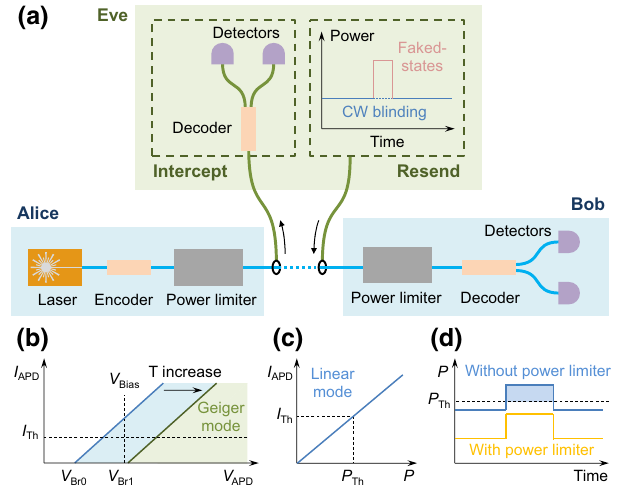
FIG. 8. (a) A schematic of the detector blinding attack pro- posed in Ref. [43]. (b) The current-voltage relationship of a typical APD. In normal working conditions, the breakdown volt- age is V Br0 . A fixed bias voltage V Bias > V Br0 enables Geiger mode operation with single-photon sensitivity. The resulting out- put current above a threshold I Th is registered as a successful count. However, the breakdown voltage increases with the tem- perature T of the device. Thus, it is possible to blind the detector by driving it into the linear mode ( V Bias < V Br1 ), thus nullifying the single-photon sensitivity. (c) The current-input power rela- tionship of an APD operating in linear mode. By controlling the input power below or above the power threshold P Th , the detector could be controlled to register fake states. (d) The input power on Bob’s detector with and without a power